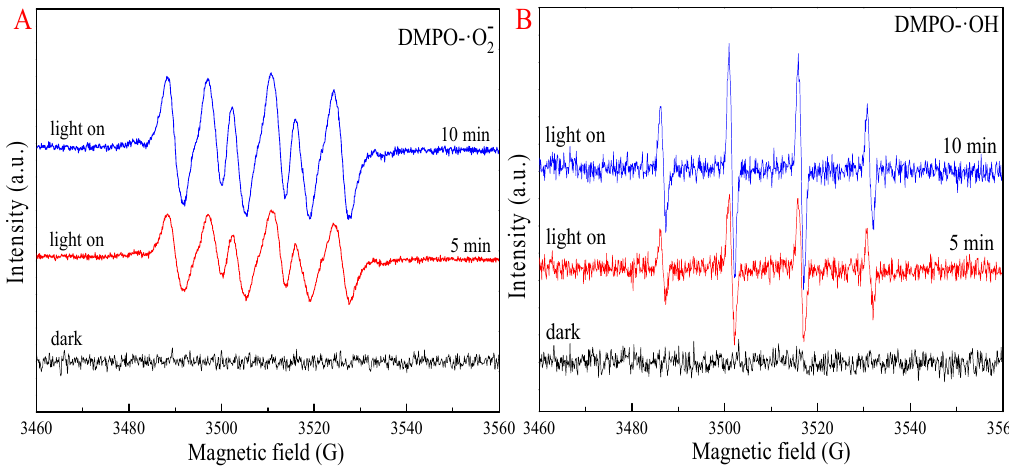
Figure 8. Photocatalytic stability of 3-Ag/CeO 2 @C-2 in Cr(VI) removal in the visible-light region.